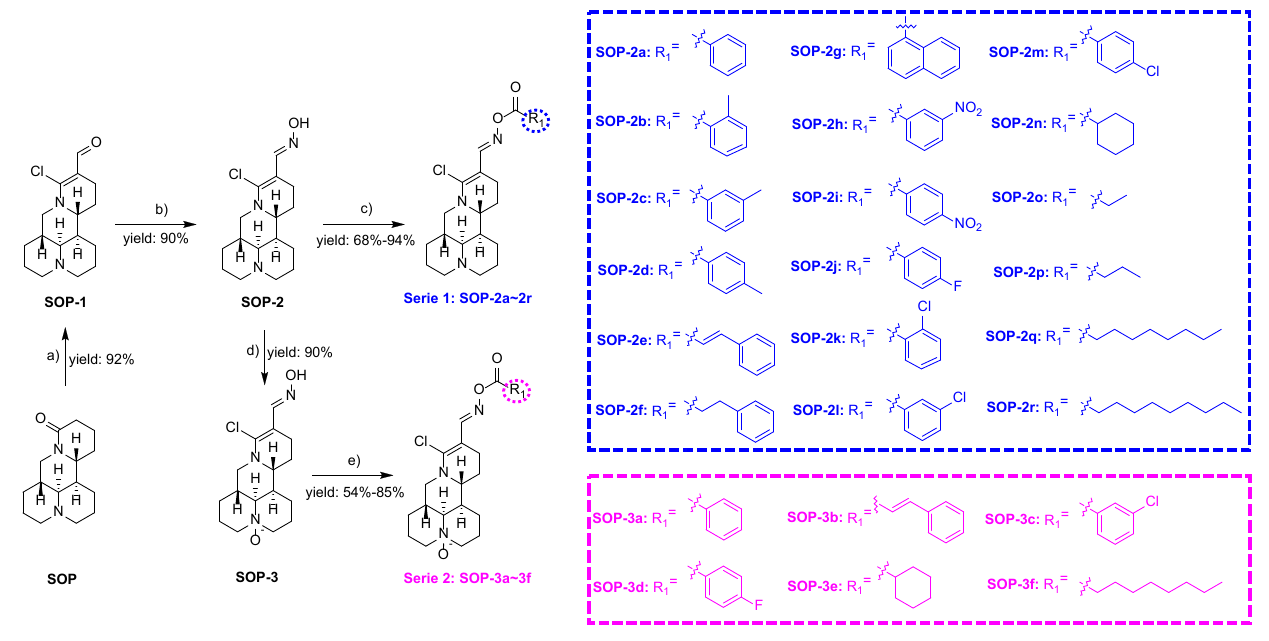
Scheme 1. Synthetic route for sophoridine derivatives. Reagents and conditions: (a) DMF, POCl 3 , 60